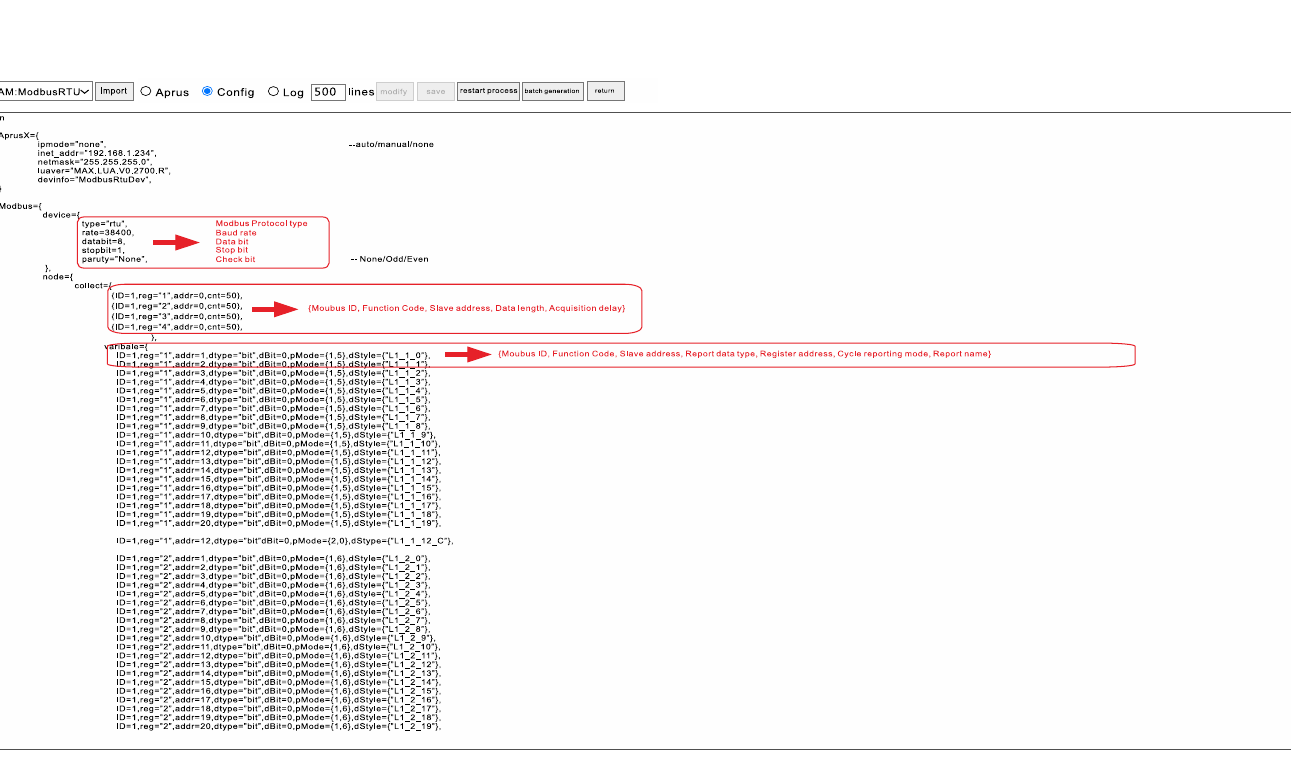
Fig 3. Data interaction rule code.